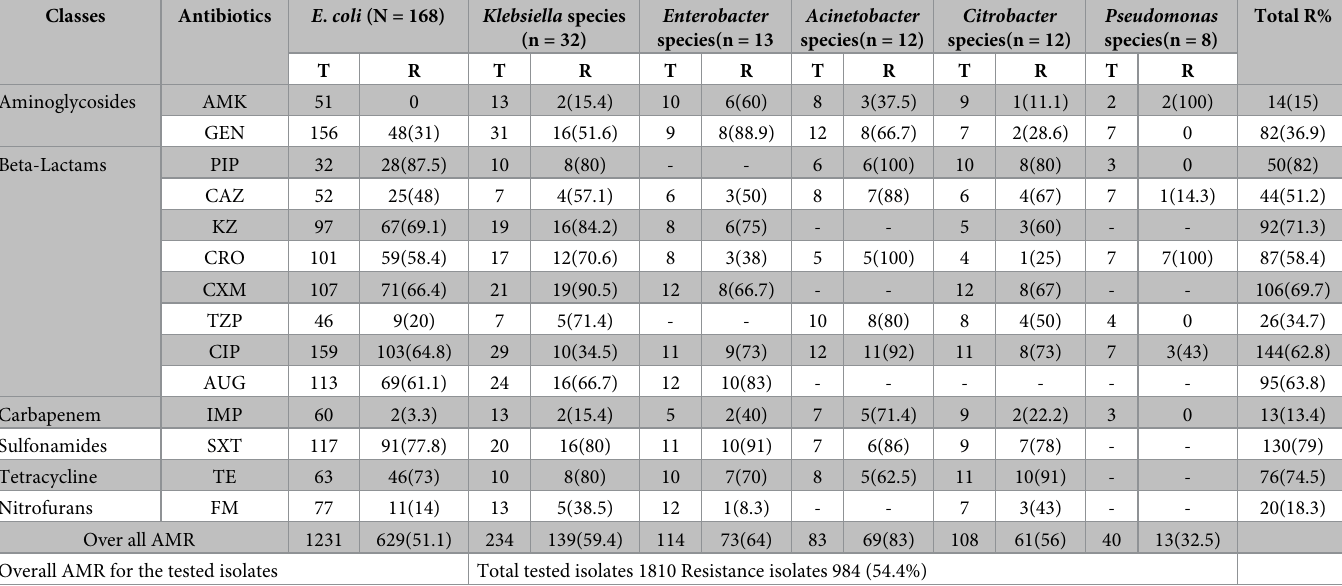
Table 4. Resistance profiles of gram-negative isolate uropathogens.